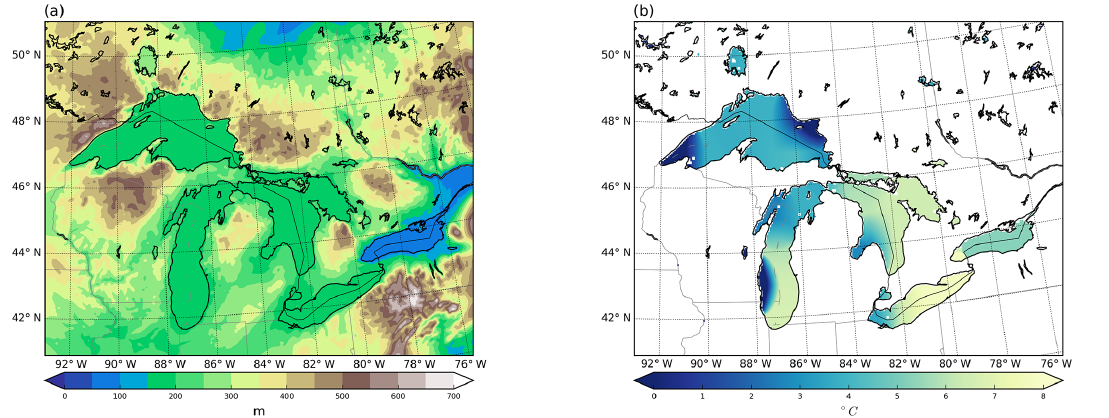
Figure 10. Topography of the nested domain (m) (a) and lake surface temperature of the Great Lakes ( ◦ C) (b) on 18 November 2014 at